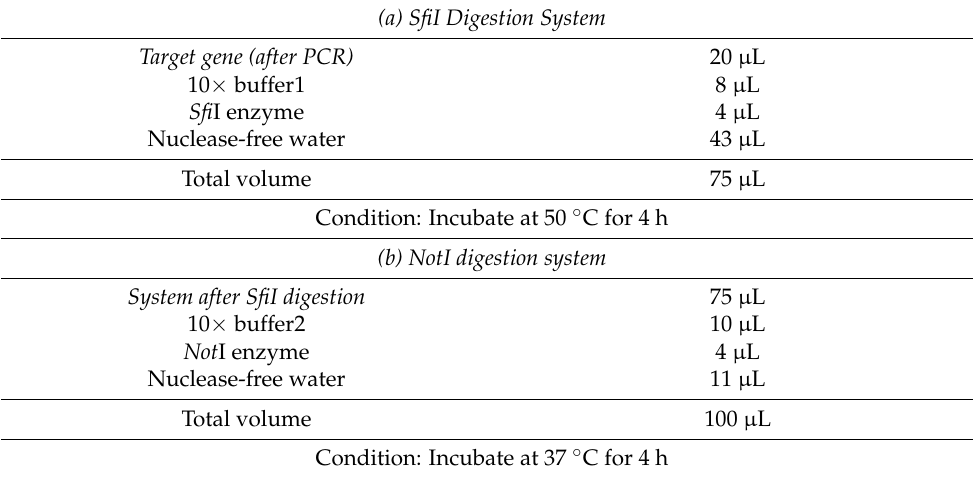
Table 8. Conditions for double digestion preparation [45].